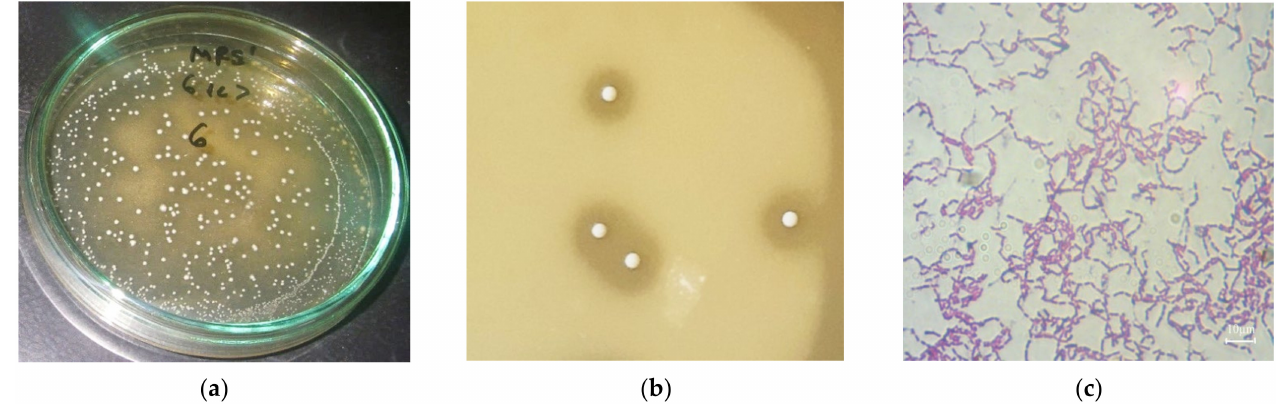
Figure 1. Macro- ( a , b ) and microscopic ( c ) aspect of the lactic acid bacteria colonies and Gram- stained cells.